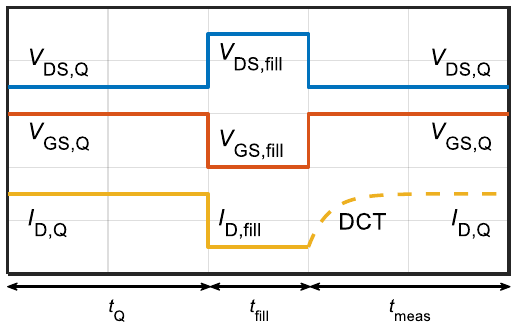
Figure 4. Illustration of signal waveforms employed during the DCT characterization. A short (1 µ s) or long (100 s) trap-filling pulse was applied by driving the device in the OFF-state. Then, DUT was biased back at ( V GS,Q , V DS,Q ) and I D was measured over several time decades up to 100 s to acquire the actual DCT. Waveform values and time intervals are not in scale.